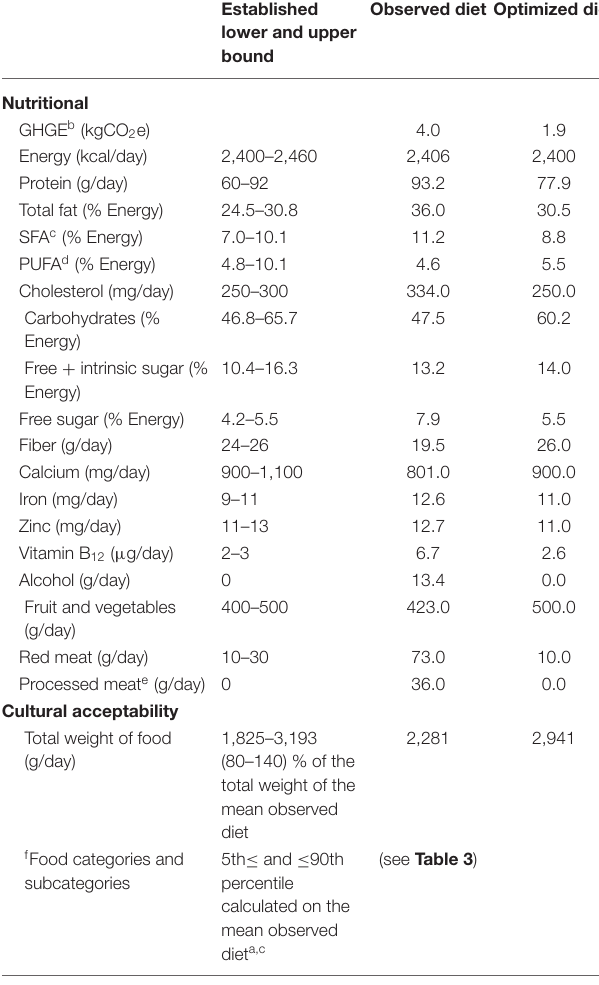
TABLE 1 | Nutritional constraints for daily intake compared with the mean observed diet (INRAN-SCAI 2005–2006) and the optimized diet from linear programming model for the adult male population, 18–60 years a